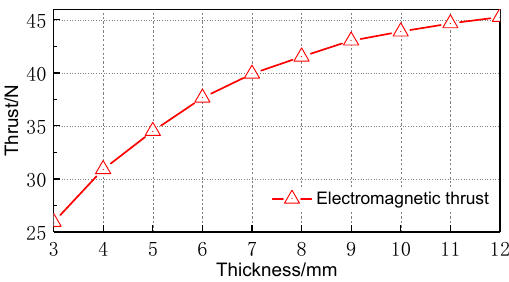
Figure 12. The curve of thrust variation with ℎ . Table 4. PM utilization ratio of different magnet thicknesses.